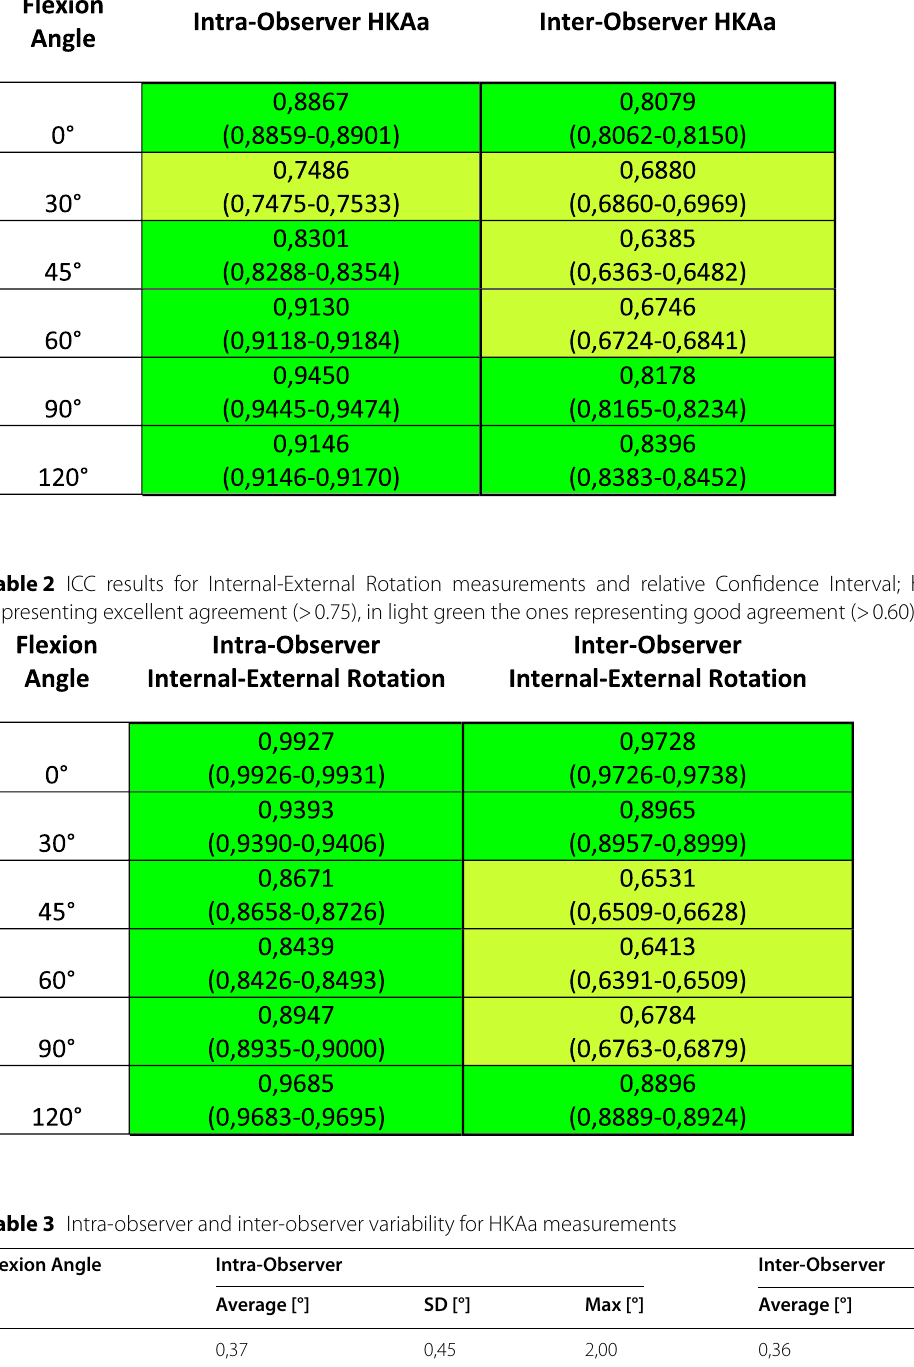
Table 1 ICC results for HKAa measurements and relative Confidence Interval; highlighted in green, the ICC representing excellent agreement (> 0.75), in light green the ones representing good agreement (> 0.60)